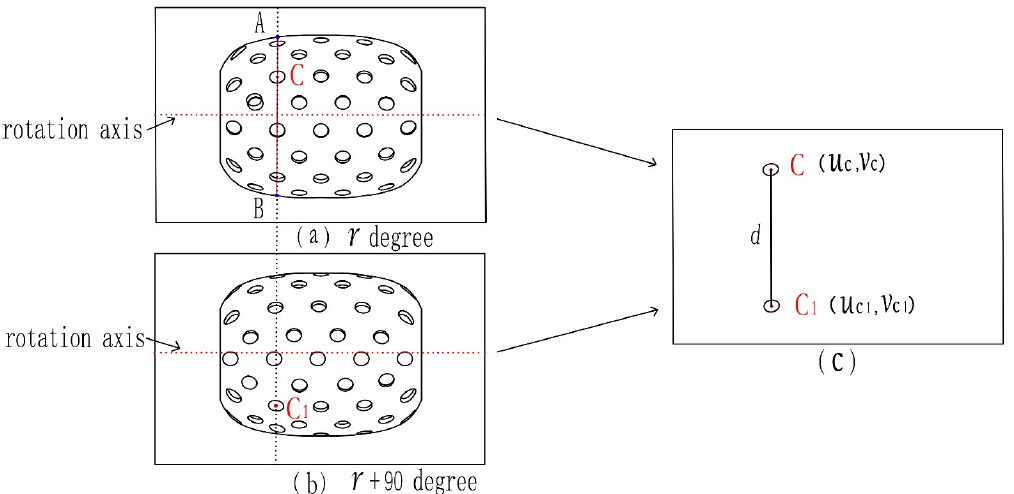
Figure 4. Epipolar constrained stereo matching. ( a ) γ degree; ( b ) γ + 90 degree; ( c ) calculate d of distance schematic diagram. The central coordinates (cid:4666)𝑢 (cid:3030) , 𝑣 (cid:3030) (cid:4667) and (cid:4666)𝑢 (cid:3030)(cid:2869) , 𝑣 (cid:3030)(cid:2869) (cid:4667) are used to describe the position of